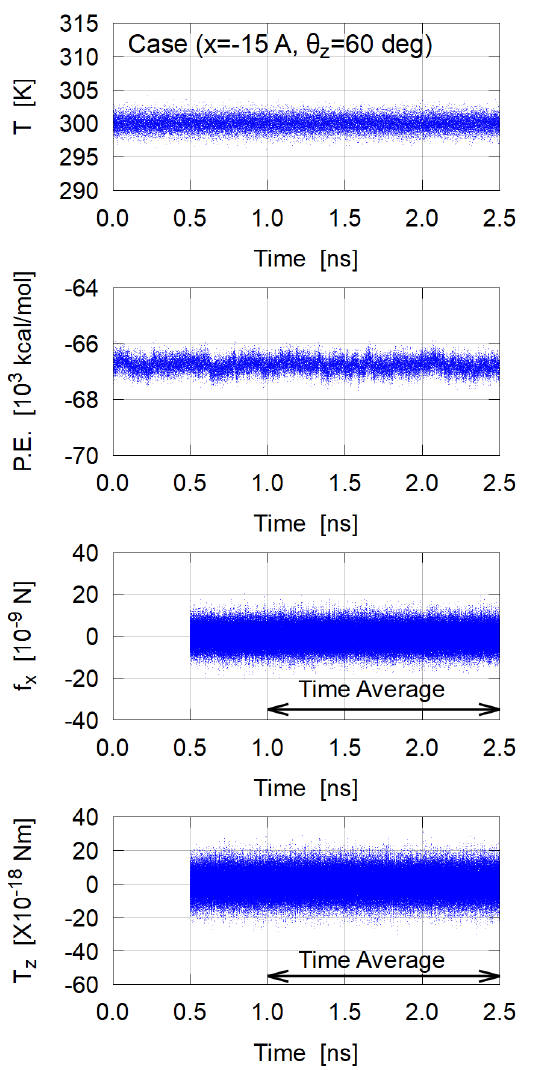
Figure 4. Variations of temperature T , potential energy (P.E.), force component f x , and torque component T z ; an example of ( x = − 15Å, θ z = 60 ◦ ) case. In this case, (cid:104) f x (cid:105) = − 0.2068 × 10 − 9 N and (cid:104) T z (cid:105) = 0.3921 × 10 − 18 Nm were obtained as the time average over